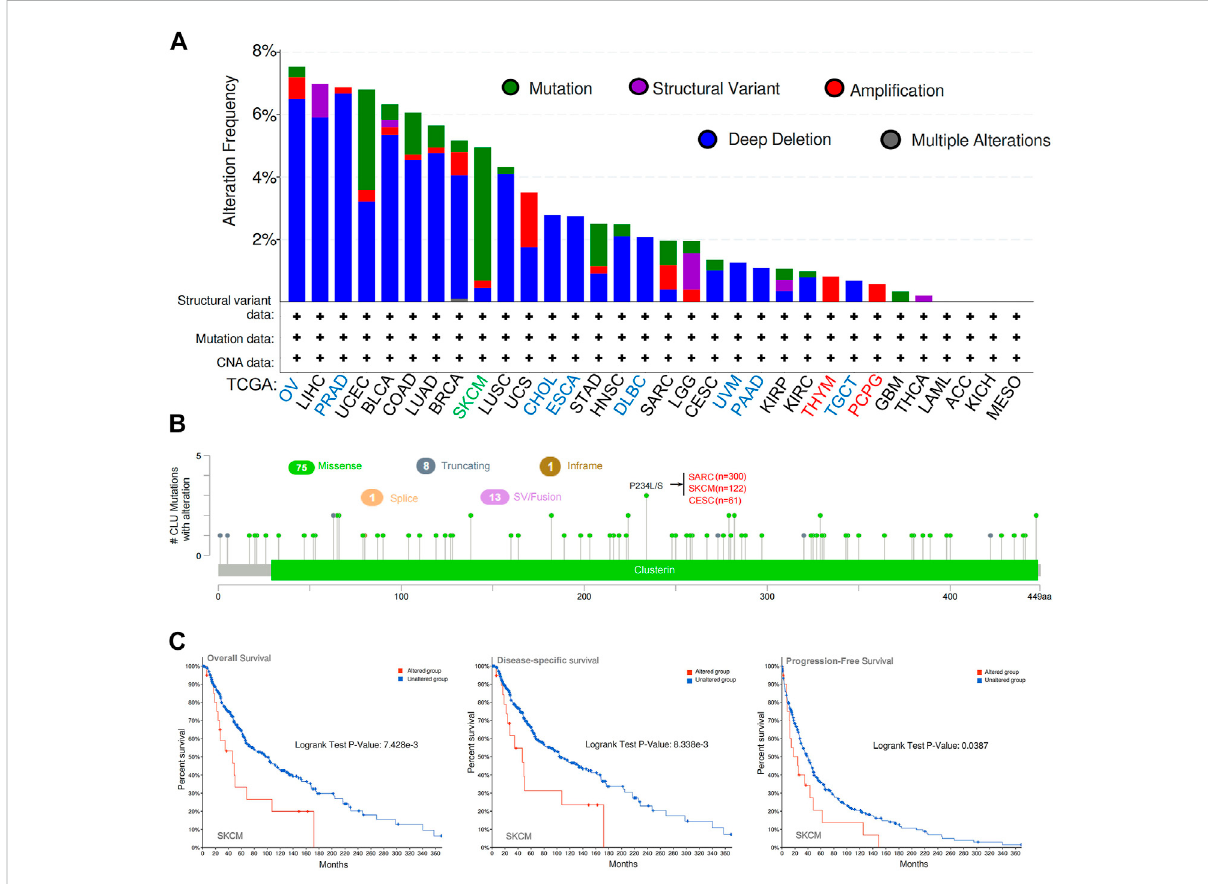
FIGURE 4 cBioPortal was utilized to examine CLU gene ’ s mutation features and prognostic value in several TCGA cancers. (A) mutation type and frequency of modi fi cation in diverse cancers; (B) CLU mutation location; (C) probable correlation between CLU mutation status and SKCM OS, disease-speci fi c, and PFS